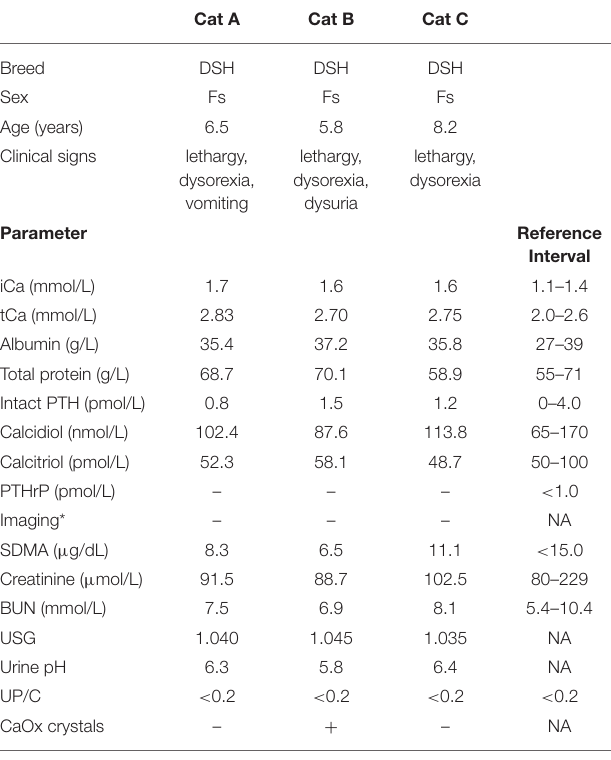
TABLE 1 | Signalment, symptoms and main diagnostics’